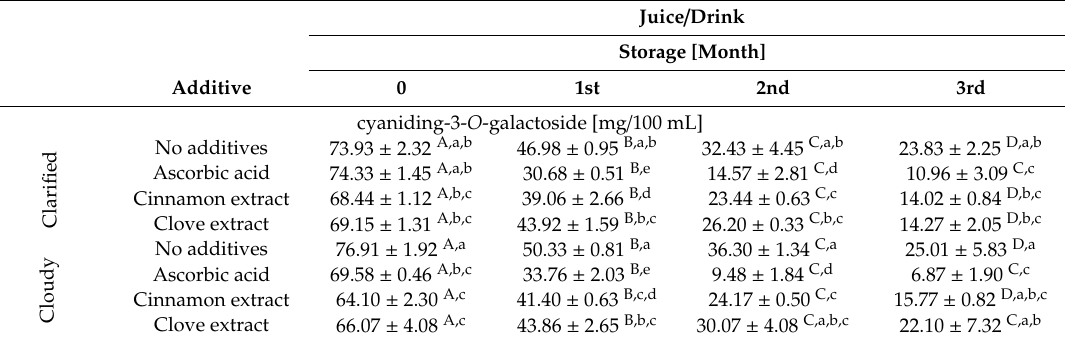
Table 6. Changes in anthocyanin content during storage of tested juices /